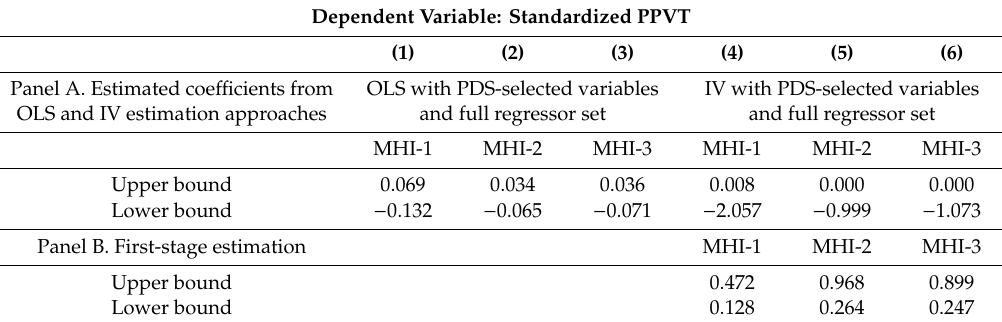
Table A3. Confidence intervals of Table 3.